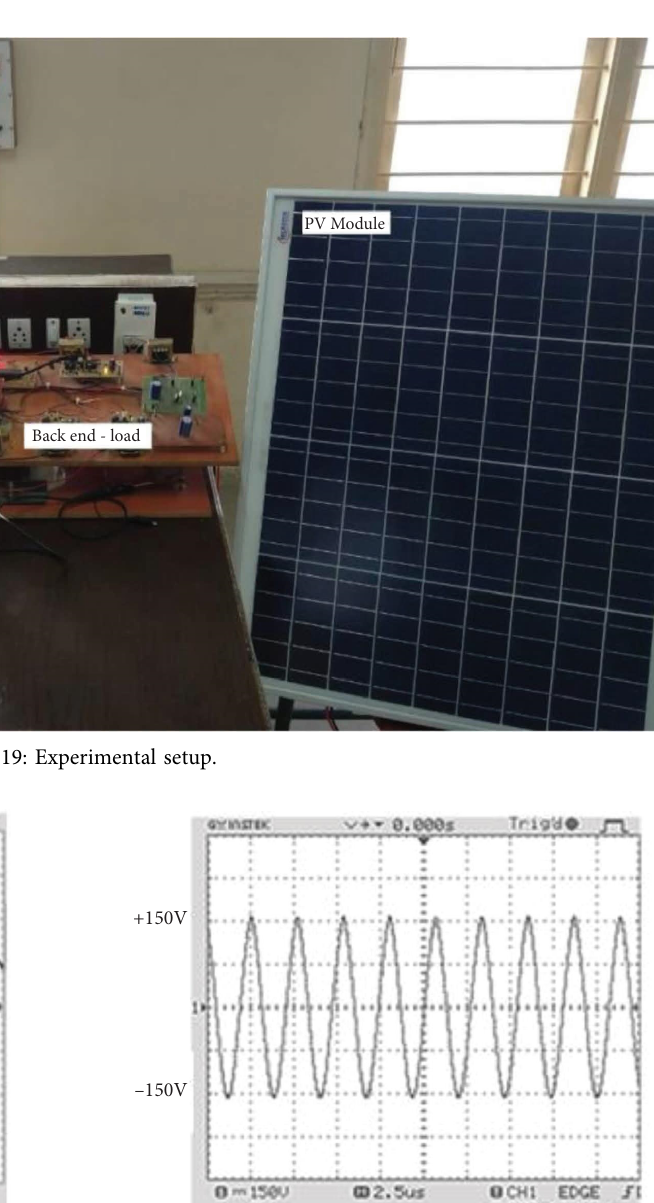
Figure 20: Output voltage waveform when + V